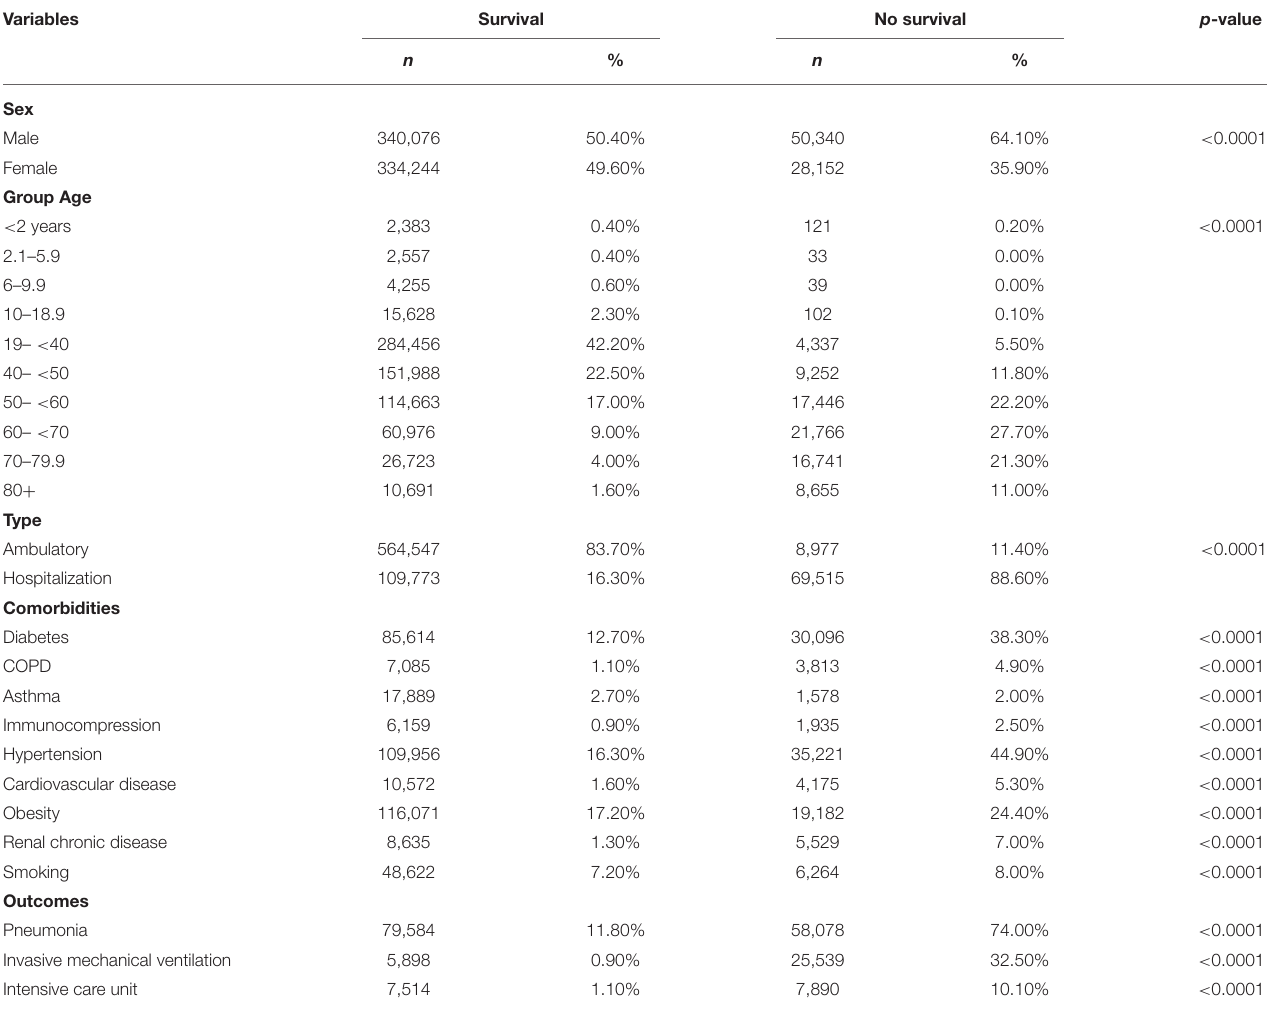
TABLE 2 | Differences between survivors and non-survivors with SARS CoV-2.